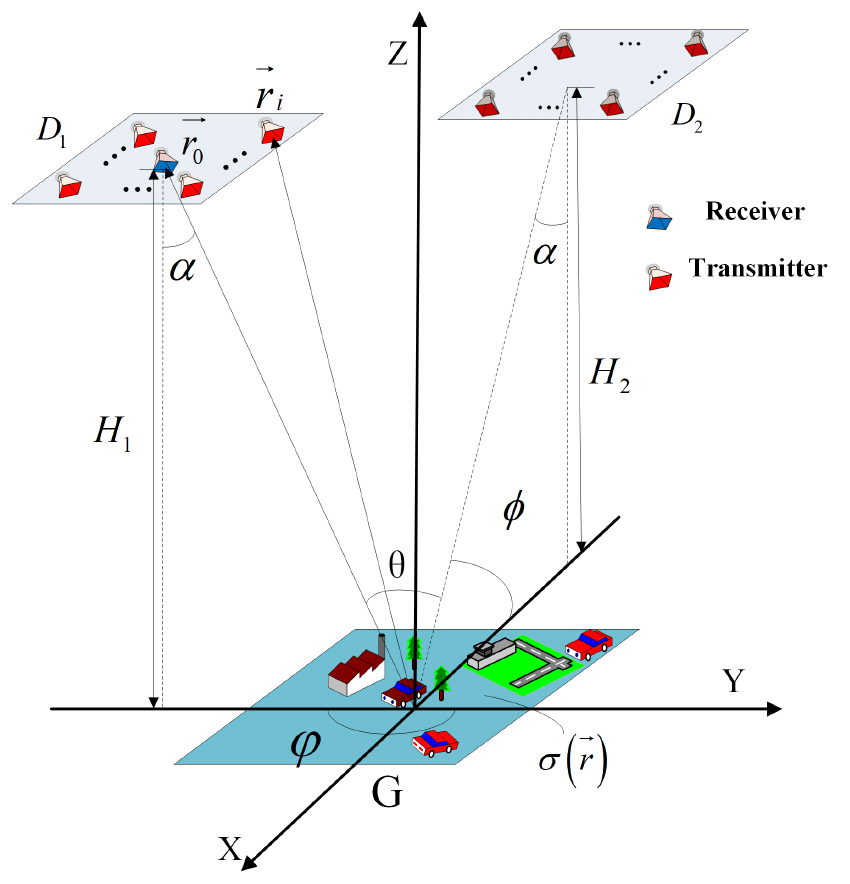
Figure 2. The proposed imaging geometry of bi-static